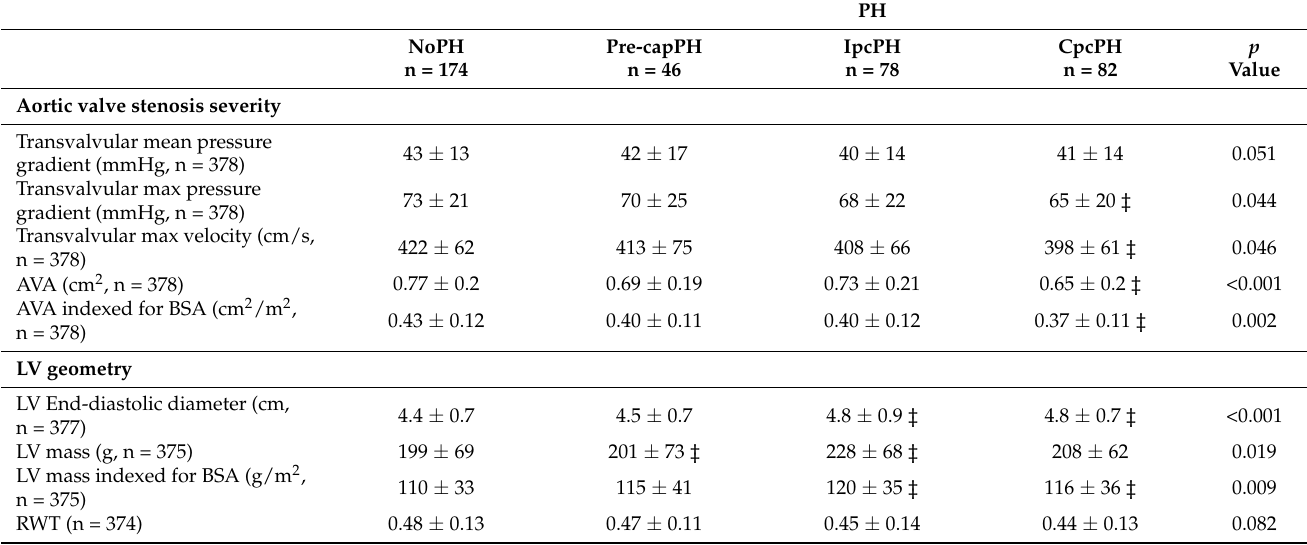
Table 3. Echocardiographic parameters according to the PH